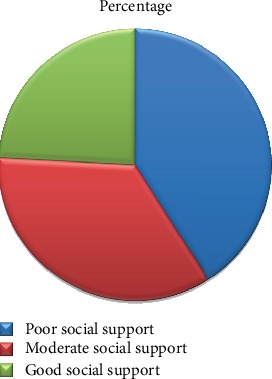
Distribution of the level of social support among high school students at Aksum town, 2019 (n = 624).